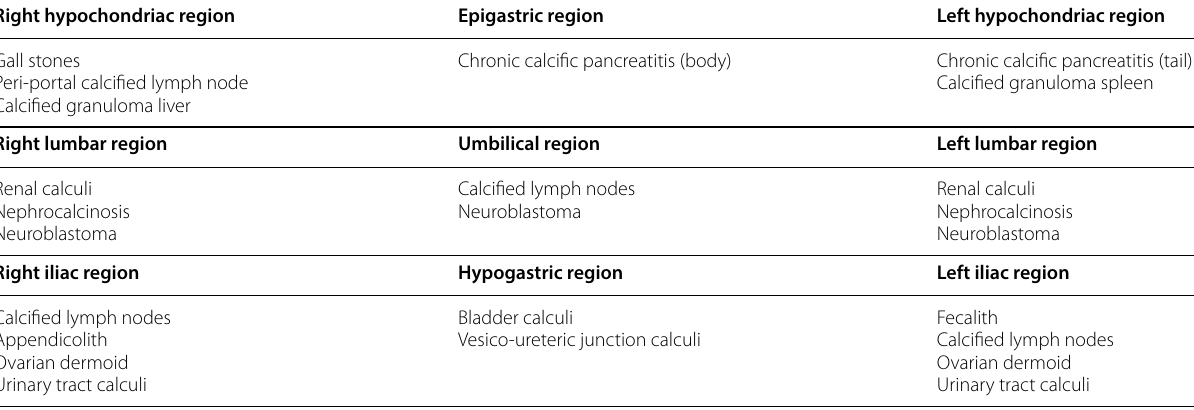
Chronic calcific pancreatitis (body)